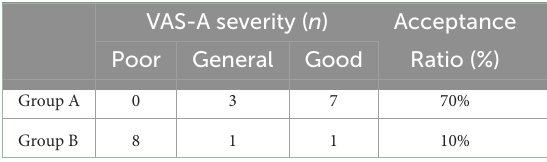
TABLE 9 The correlation between acceptance ratio and VAS-A severity.